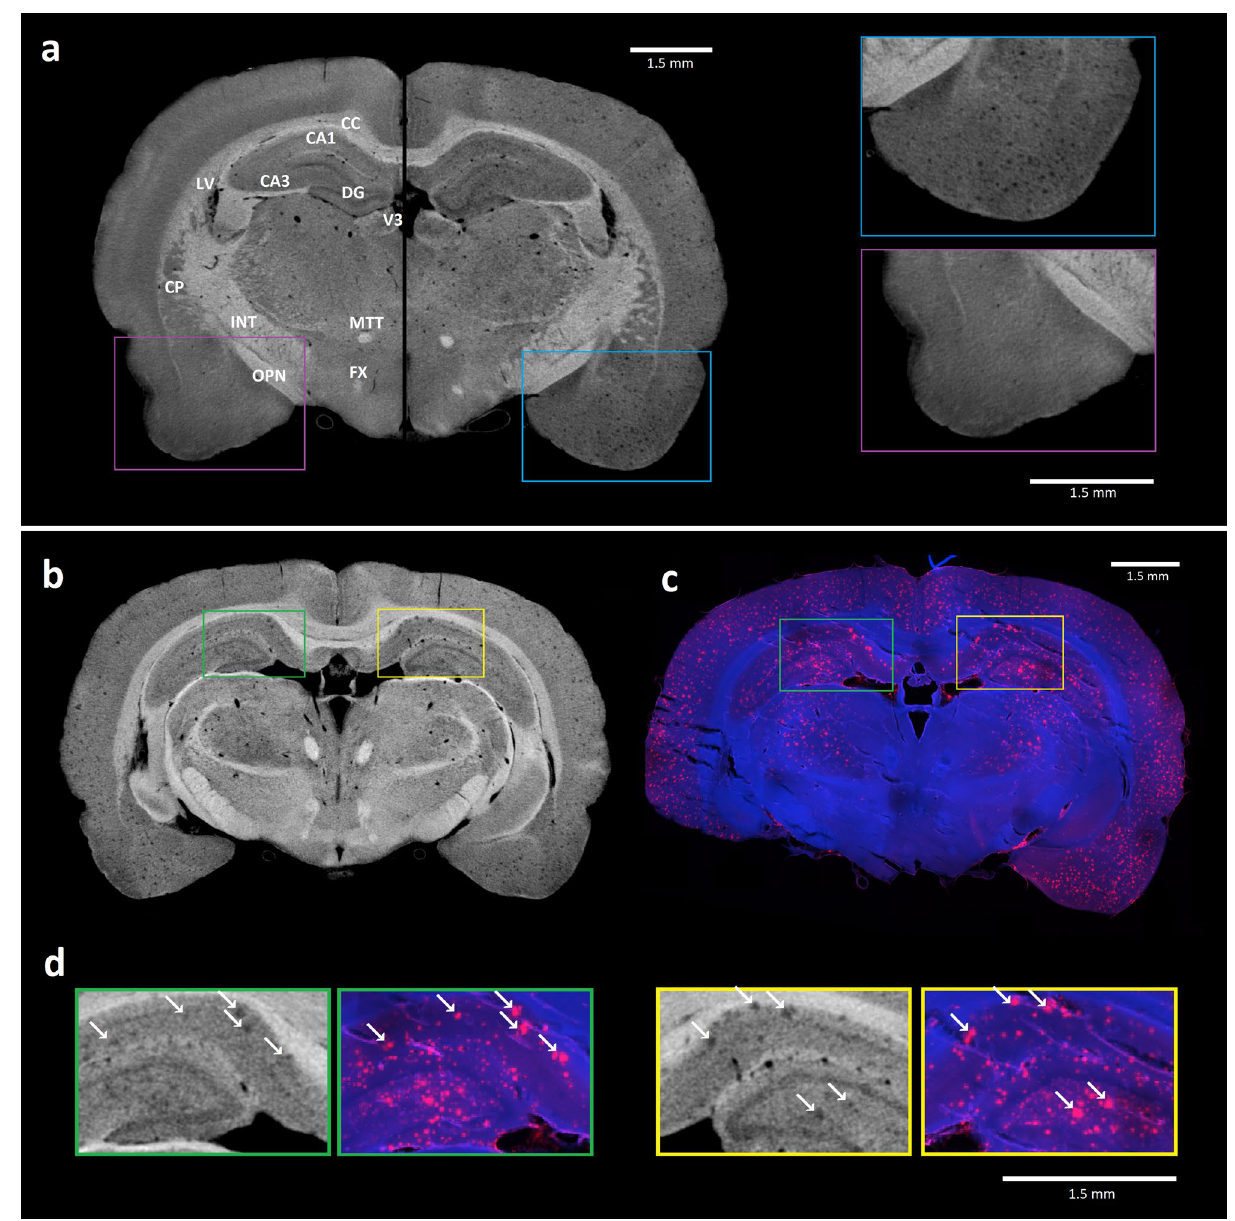
Figure 1. Confirmation of plaques identity in micro CT data: ( a ) Composed picture of the micro CT scan sections from control (left side) and transgenic (right side) rat brain. The transgenic tissue exhibits a large amount of suspect amyloid plaques (right part of the brain). Selected detail image of corresponding areas that are shown in pink and blue frames. Basic anatomical structures visualized in micro CT scan: CA1 and CA3 cornu Ammonis 1 and 3 of hippocampus, CC corpus callosum, CP caudoputamen, DG dentate gyrus, FX fornix, INT internal capsule, LV lateral ventricle, MTT mamillothalamic tract, OPN olivary pretectal nucleus, V3 third ventricle. Micro CT image ( b ) and immunohistology section with detected plaques ( c ) of corresponding coronal brain sections from the transgenic rat no. 60 confirms the presence of plaques in micro CT scan. Selected plaques are indicated by white arrows in enlarged slice windows ( d ) 41